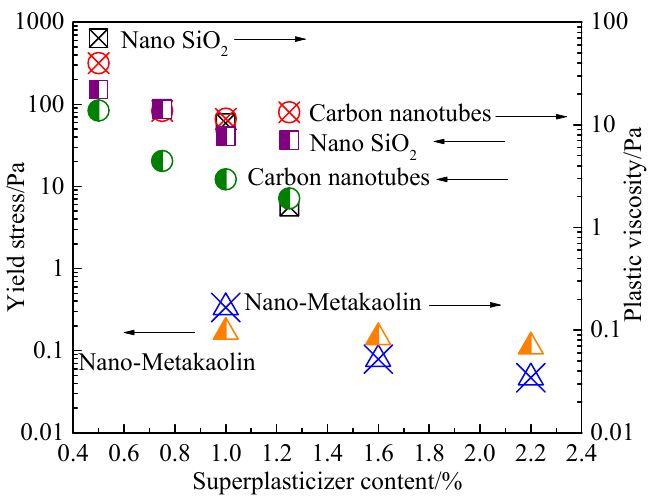
Figure 9. The relationship between rheological parameters and superplasticizer content of cement- based materials with addition of nanoparticles [8,11,94].